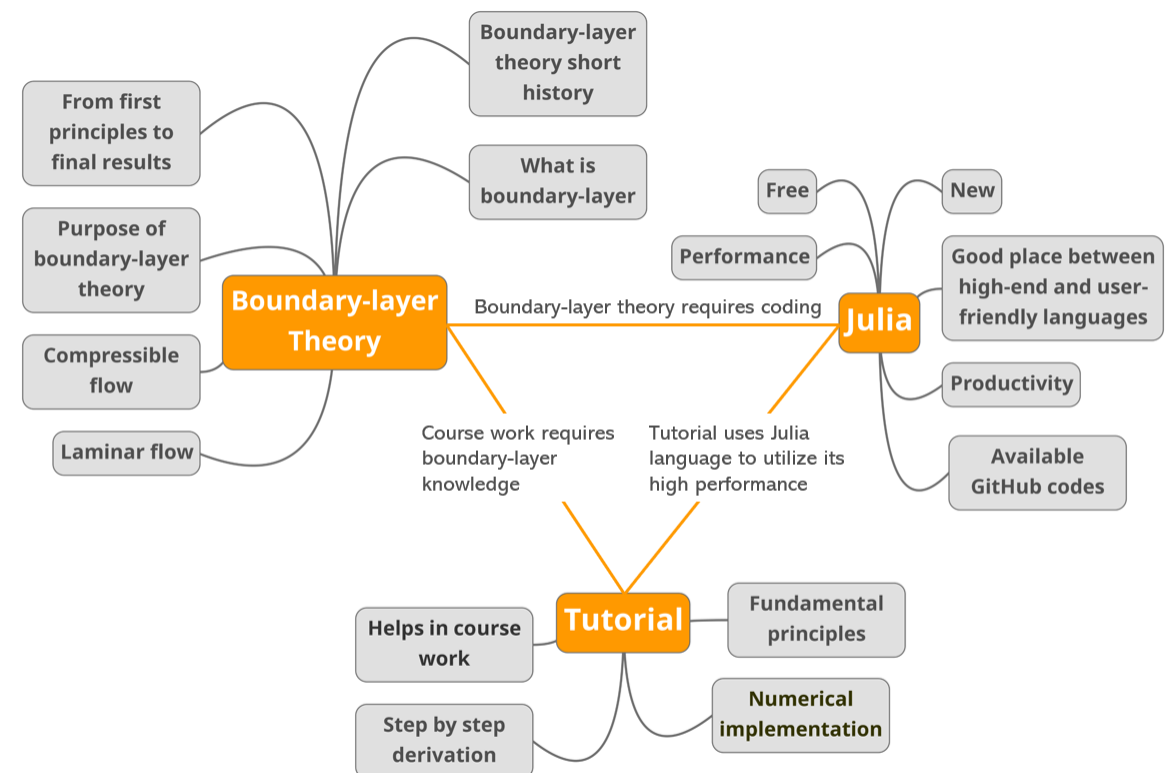
Figure 1. The visual abstract of the present paper which is mainly designed around 3 major points. Major points are further divided into smaller points which correspond to purposes/ideas of the particular major point. Each major point is connected to one another, which makes them